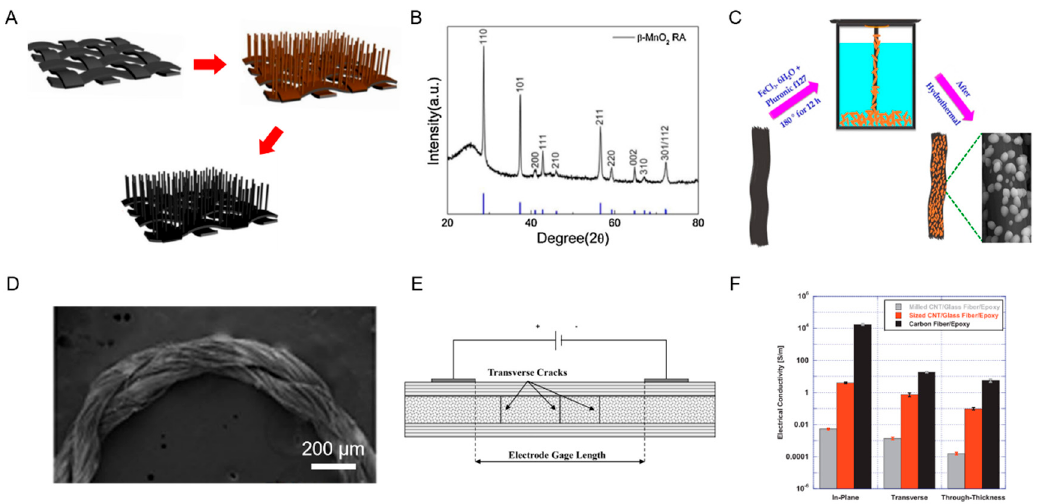
Figure 5. ( A ) Schematic depiction of fabrication of β -MnO 2 nanorod array on CF fabric. ( B ) XRD pattern of β -MnO 2 nanorod array. Reproduced with permission from [54]. ( C ) Illustration of the hydrothermal process of generating Fe 2 O 3 / conductive carbon yarn (CCY) hybrid electrode. ( D ) the Field Emission SEM (FESEM) image of the Fe 2 O 3 / CCY electrode. Reproduced with permission from [55]. ( E ) Schematic of transverse crack insertion between the electrode gage length. ( F ) Electrical conductivity summary for different carbon-based composite polymers. Reproduced with permission from [64].